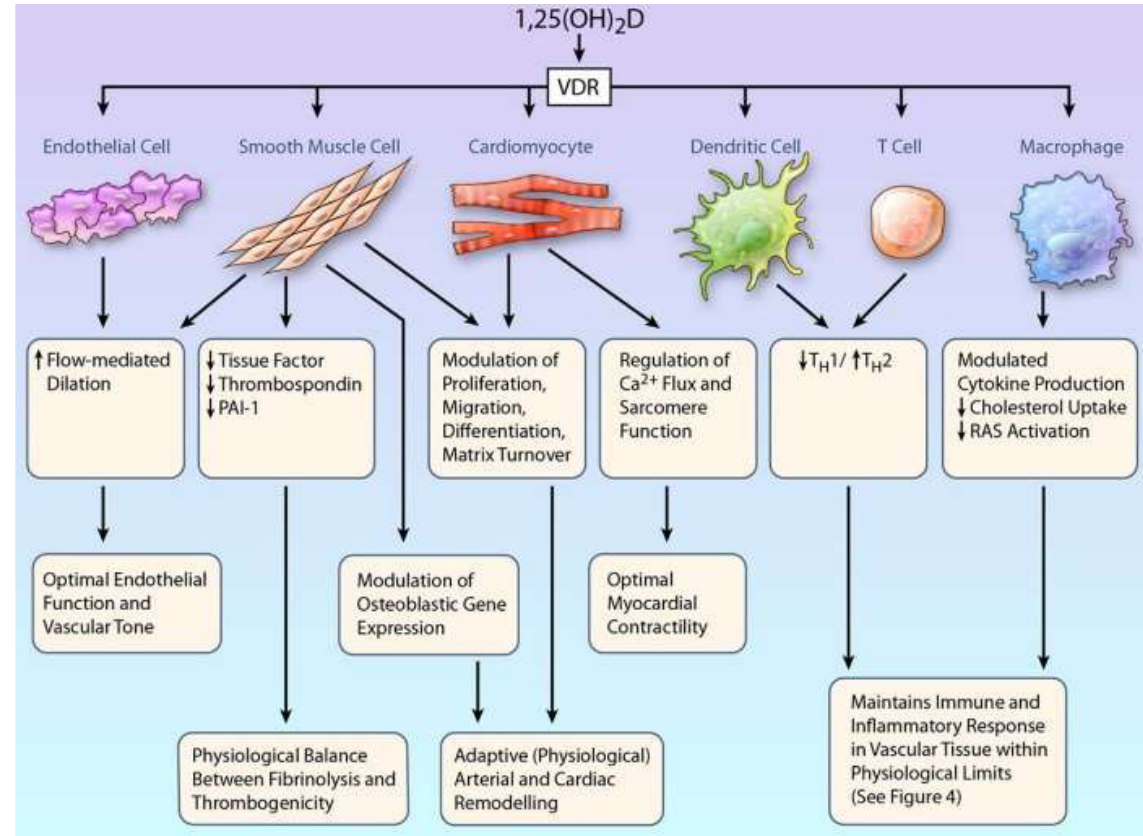
Figure 2. Overview of the cardiovascular system-related impacts of vitamin D (TSP: thrombospondin, PAI-1: plasminogen activator inhibitor-1, RAS: renin-angiotensin system, T H 1: T helper type 1 cell, T H 2: T-helper type 2 cell; “See Figure 4” refers to Figure 4 of the original article by Norman PE and Powell JT [1] ). Figure reproduced from “Vitamin D and cardiovascular disease” by Norman PE and Powell JT, Circ Res 2014, 114, 379–393, doi:10.1161/circresaha.113.301241. [1] with permission of the publisher. Copyright 2014, American Heart Association, Inc.